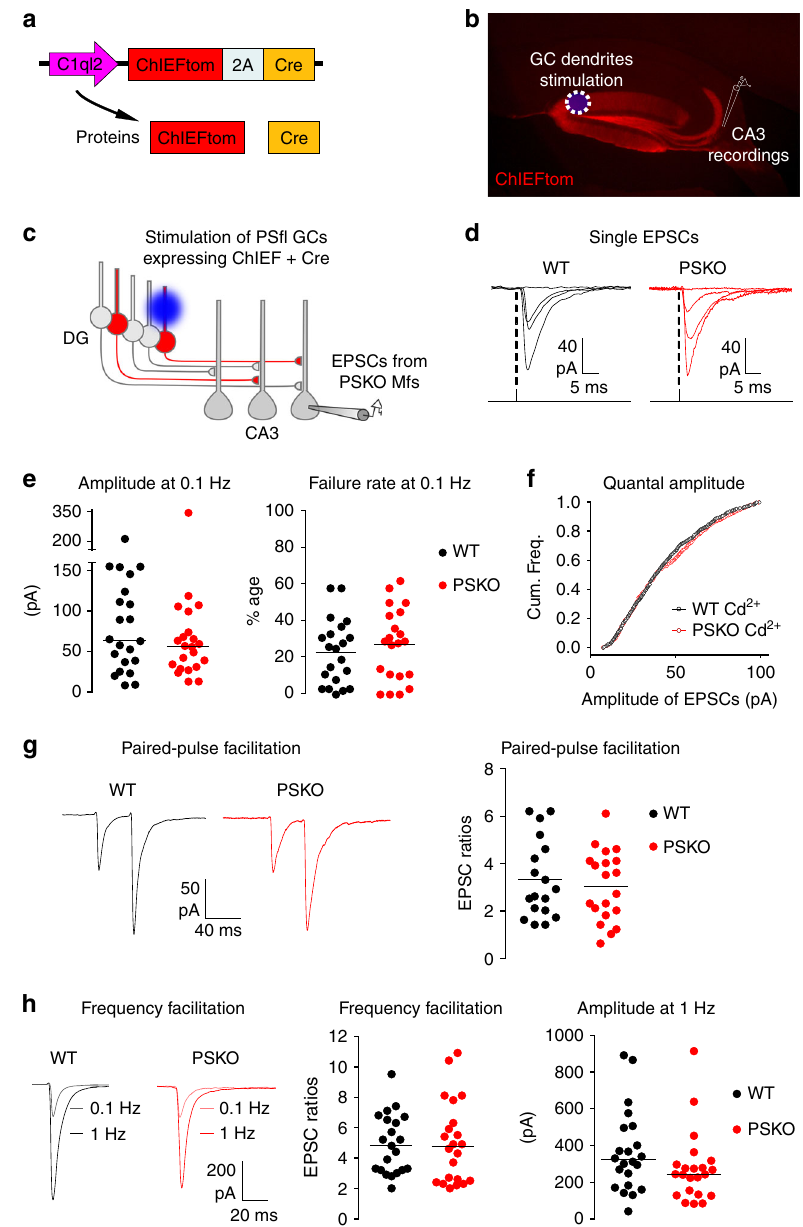
Fig. 1 Study of PS presynaptic function at Mf/CA3 synapses using an optogenetic strategy. a Scheme of lentiviral construct which co-expresses ChIEF fused to the fl uorescent protein tomato and the Cre recombinase. The promoter C1ql2 restricts expression to DG granule cells (GCs). b Picture of a parasagittal section of a mouse brain injected with a virus coding for ChIEFtom. c Strategy to selectively study Mf/CA3 synapses that are PSKO presynaptically and intact postsynaptically. The blue light triggers the fi ring of granule cells that express ChIEF and by obligation (bicistronic construct) the Cre recombinase. In PS “ fl oxed ” conditional knock-out mice, the activated GCs do not express PS; EPSCs evoked in CA3 neurons by light pulses in the DG arise from presynaptic PSKO Mf terminals. d Representative traces of CA3 EPSCs evoked by single light-pulses focused as in ( b ). e Basal transmission at Mf/CA3 synapses is not altered by PS genotype. Scatter plots with medians of the amplitude, and means of the failure rate of EPSCs recorded in CA3 neurons at 0.1 Hz in WT or PSKO condition ( n = 22/genotype). f Cumulative frequencies of EPSCs amplitude in presence of Cd 2 + . g Representative recordings of paired-pulses EPSCs evoked by two light-pulses separated by 40 ms, and analyses of paired-pulse ratio. The facilitation is represented by the amplitude of the second EPSC normalized to the amplitude of the fi rst EPSC. h Representative traces of EPSCs evoked by light-pulses at 0.1 or 1 Hz, and analyses of facilitation. The frequency facilitation is represented by the amplitude of EPSCs obtained at 1 Hz normalized to the amplitude of EPSCs obtained at 0.1 Hz. The raw amplitude of EPSCs at 1 Hz does not differ between WT and Fig. 2b). Overall, inactivation of PS at Mf-CA3 synapses The broad dynamic range of EPSC amplitudes from failures neither affected release probability nor quantal amplitude under (0.1 Hz) to large currents in response to high-frequency bursts of basal conditions, but strongly decreased facilitation induced by stimulation represents a high-pass fi lter for the transfer of trains of Mf stimulation by affecting short-term plasticity information at Mf-CA3 synapses. We explored the impact of the mechanisms. short-term plasticity de fi cit on spike transfer at DG-CA3